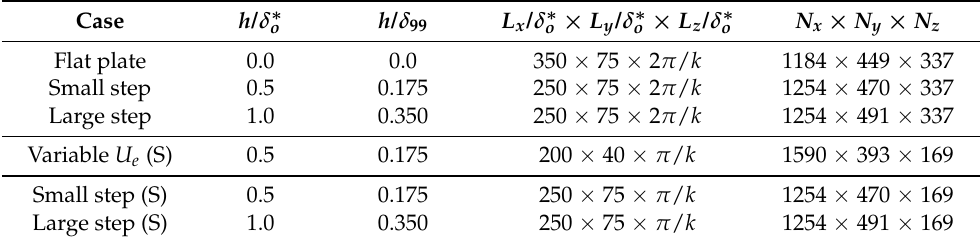
Table 1. Numerical setup for the boundary layers over backward-facing steps. (S) denotes cases in which symmetry boundary conditions were applied at z = 0.